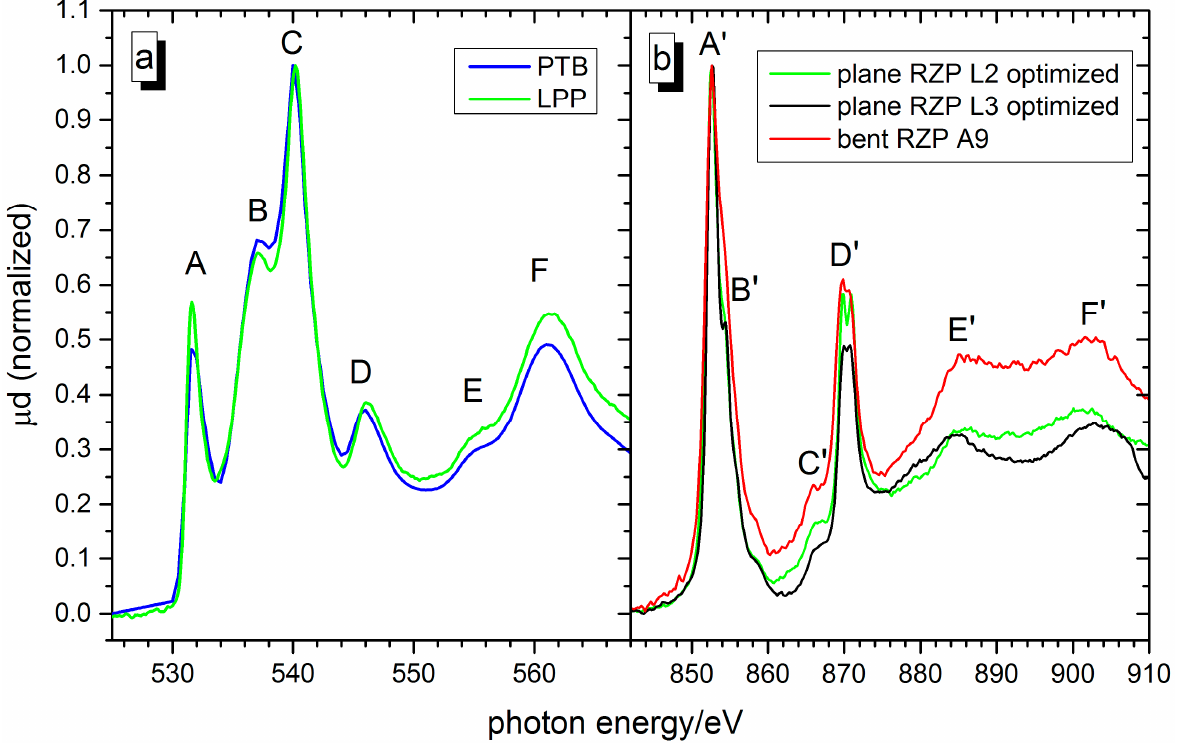
Figure 4. ( a ) Oxygen K-edge NEXAFS spectra of a NiO thin film measured with the sub-ns laser plasma source (green) and at the PTB/BESSY II synchrotron beamline (blue). ( b ) Nickel L-edge NEXAFS spectra of a NiO thin film measured with the sub-ns laser plasma source and an RZP on plane substrate optimally aligned for the L2-edge (black) and L3-edge (red), respectively. For comparison, the spectrum (green) recorded with the ps-LPP and the RZP A9 on a bent substrate is also shown.